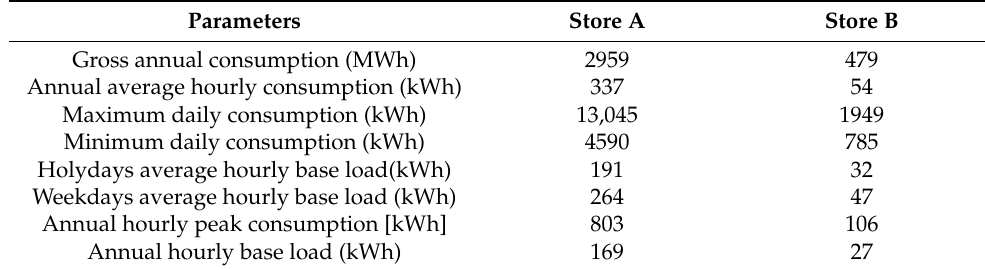
Table 5. Reference data of energy consumption for the two stores under